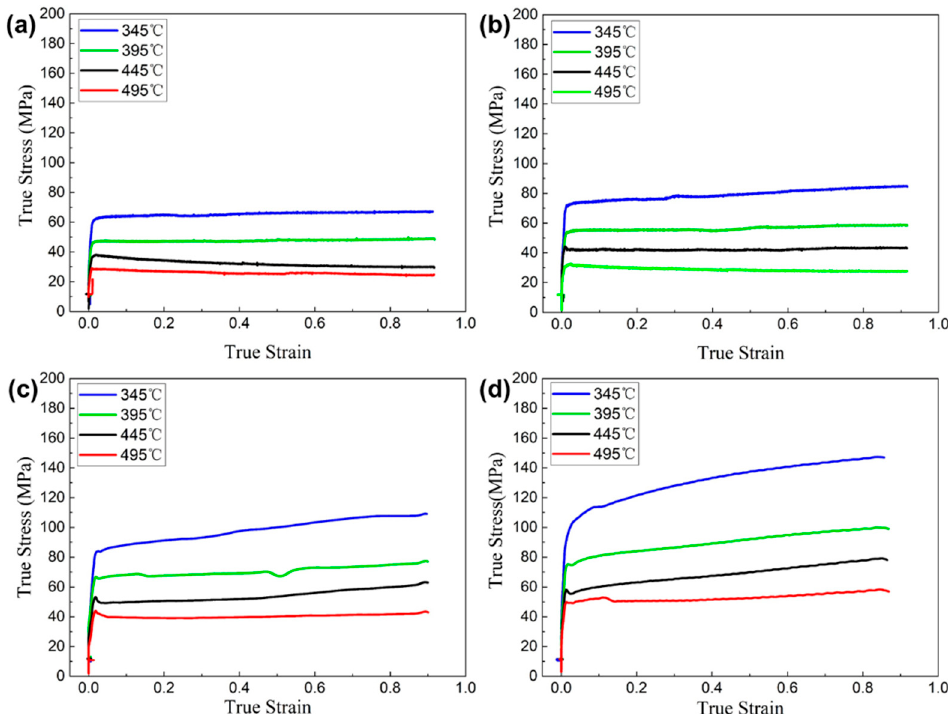
Figure 7. The true stress–strain curve of the fourth layer of gradient alloy by spray deposition: ( a ) 0.001 s − 1 , ( b ) 0.01 s − 1 , ( c ) 0.1 s − 1 , and ( d ) 1 s − 1 .